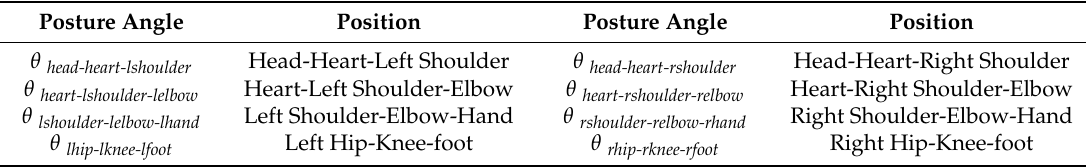
Table 3. Posture angles of human